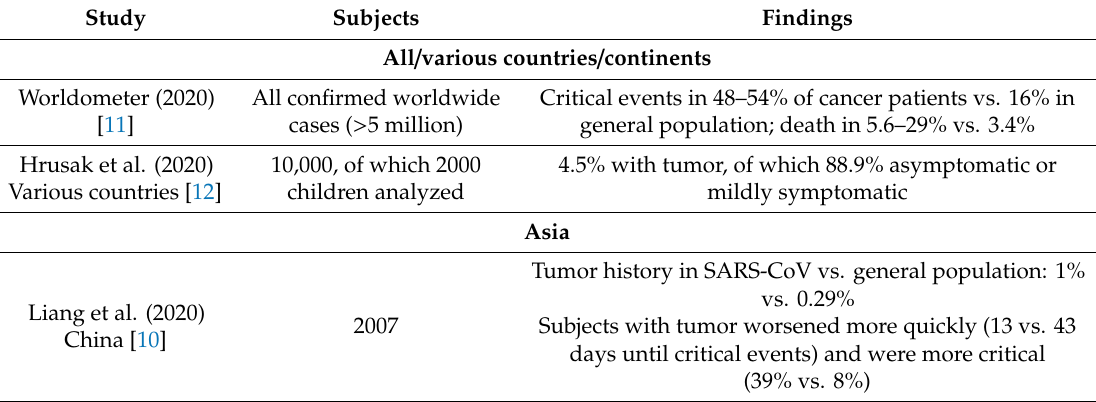
Table 1. Incidence and severity of severe acute respiratory syndrome coronavirus 2 (SARS-CoV-2) in cancer patients